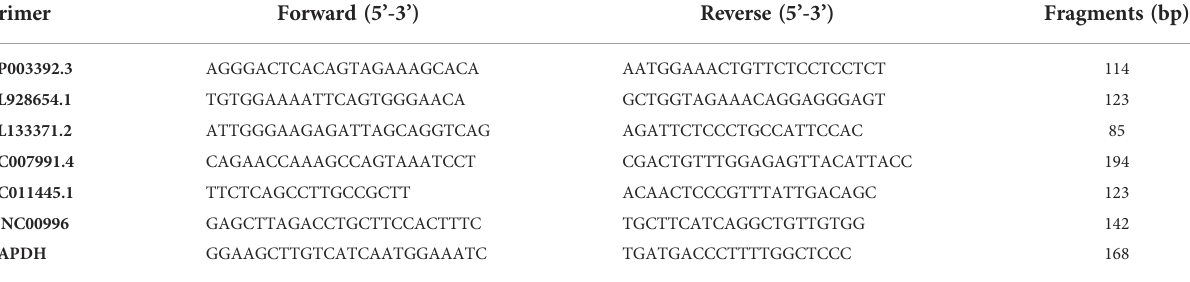
TABLE 1 Primer sequences in our